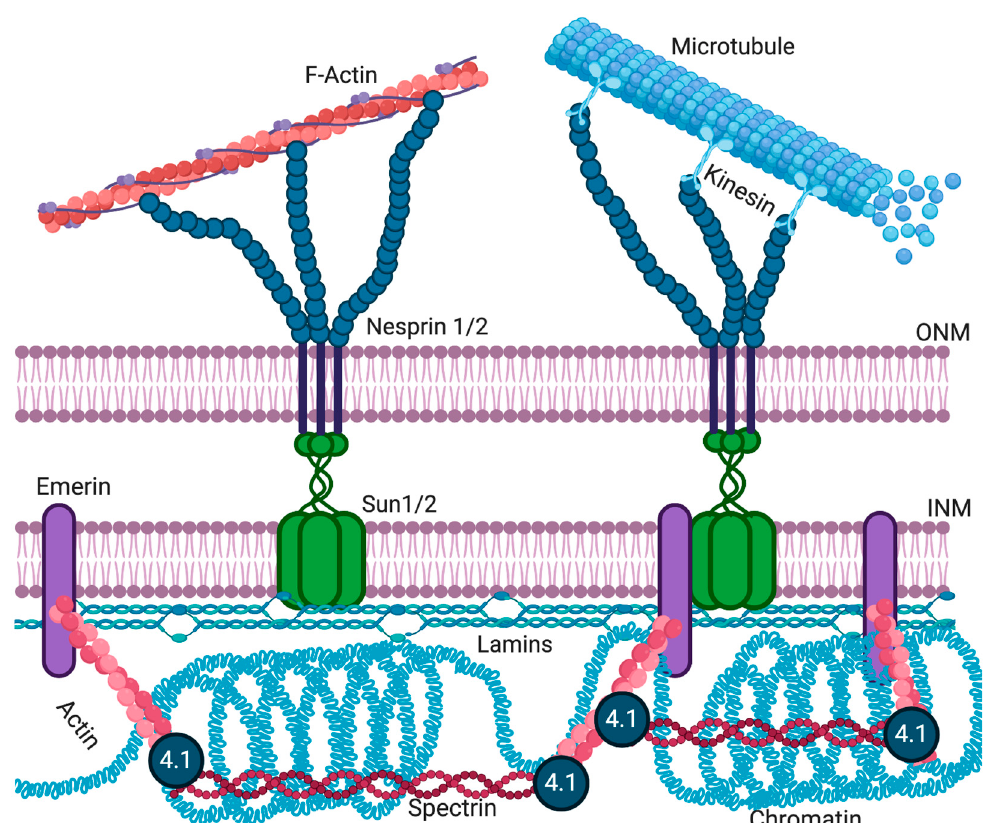
Figure 3. The LINC complex. SUN domain trimers interact with emerin and lamins at the INM. SUN domain proteins interact with KASH domain proteins (nesprins) in the periplasmic space. KASH domain proteins span into the cytoplasm to interact with the cytoskeleton, thereby connecting the nucleus to the cytoskeleton [125]. Created with BioRender.com.